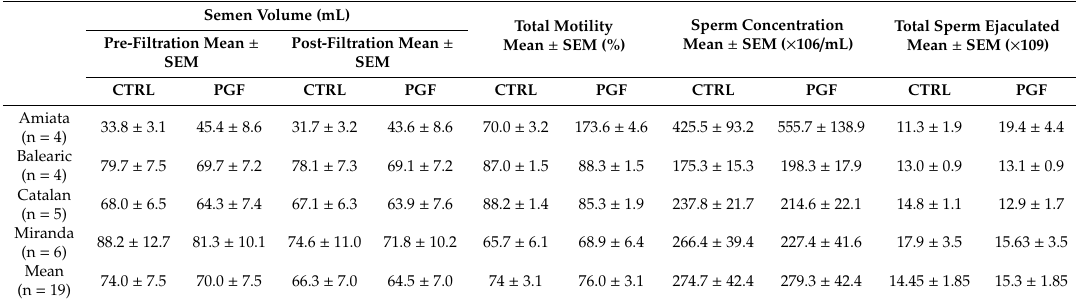
Table 3. Seminal parameters in 106 semen collections performed in 19 jacks of di ff erent breeds (Amiata, n = 4; Balearic N = 4; Catalan n = 5; Miranda n = 6). In half of the collections, jacks were treated with 125 µ g of cloprostenol sodium (PGF) or 1 mL of saline (CTRL) prior to semen collection mounting an estrus jenny ( P > 0.05).